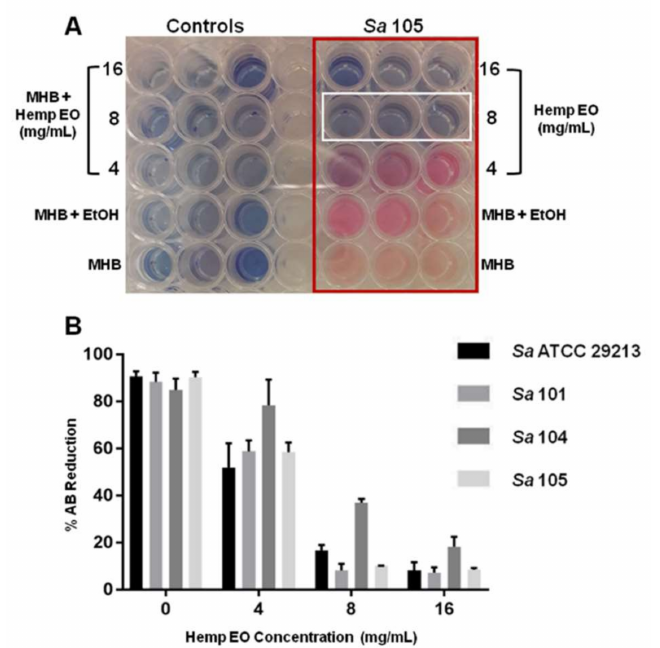
Figure 2. The evaluation of minimum inhibitory concentration (MIC) of the hemp EO versus Staphylococcus aureus determined using the alamarBlue ® (AB) assay. ( A ) Representative image of colorimetric MIC determination using AB at 24 h of incubation. The white rectangle indicates the MICs at 8 mg/mL S. aureus 101. ( B ) The plot shows the percentage reduction of AB in the S. aureus broth cultures at different hemp EO concentrations compared to the corresponding untreated samples (0) evaluated as indicated in the experimental section of this manuscript. MHB: Mueller–Hinton broth; EtOH: ethanol. Data are presented as the mean of three replicates of three independent